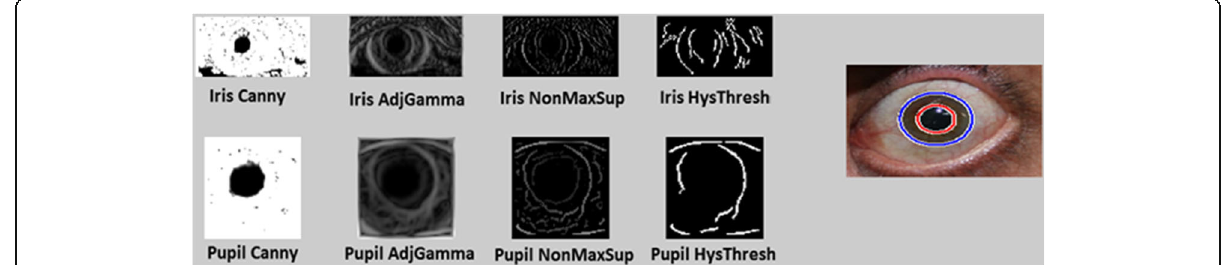
Fig. 4 Iris and pupil detection using CHT technique